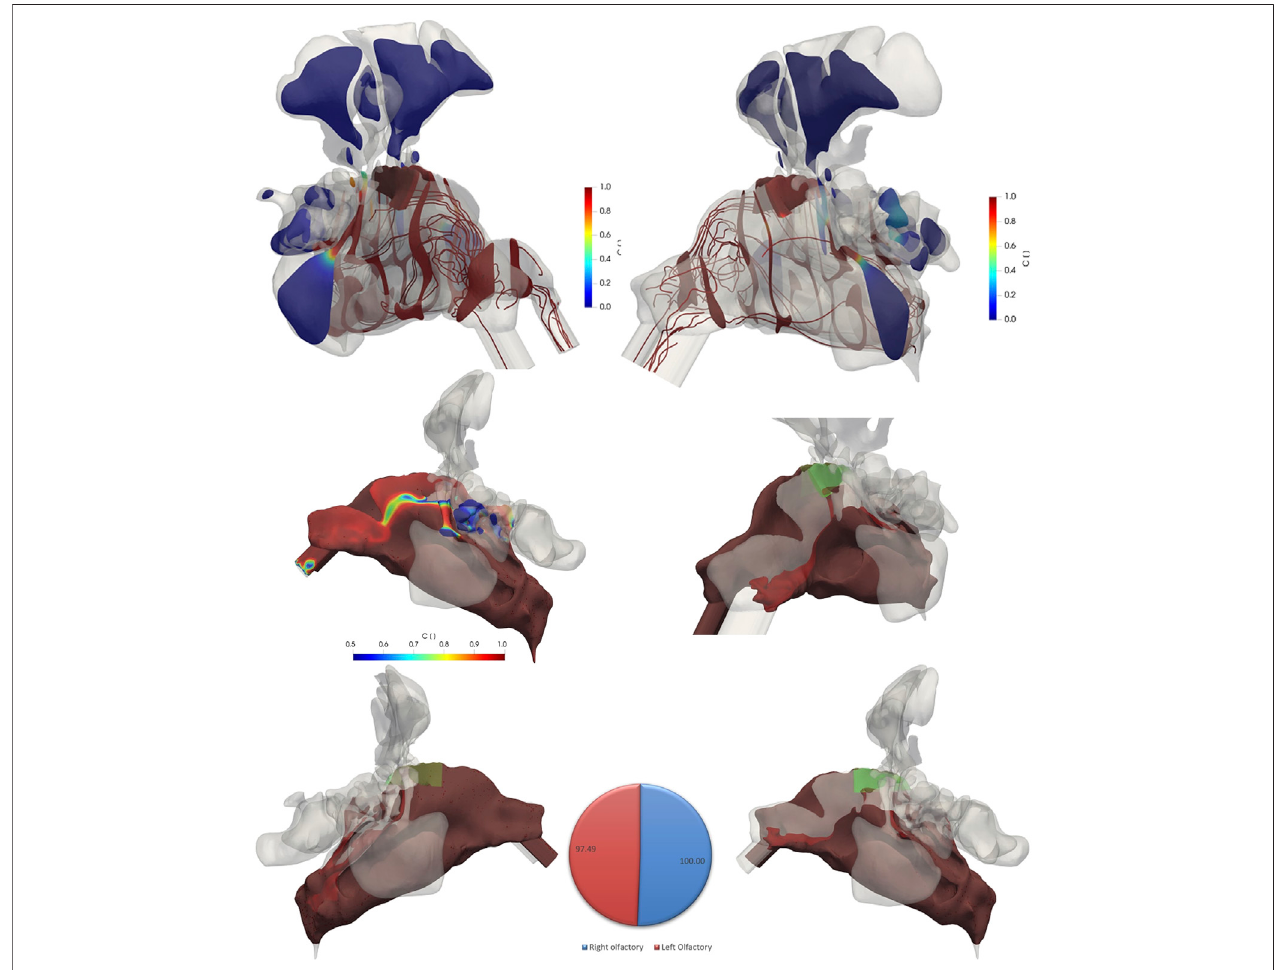
FIGURE 7 | The contour plots of variable C (drug-laden air fraction) and fl ow streamlines (color coded for C) in different regions of the nasal cavity speci fi cally in the olfactory region (green shaded) at t (cid:2) 1.98 s for pulsatile inlet fl ow of 4 L/min and frequency of 45 Hz. While the drug-laden air fraction is virtually identical to that of the non-pulsatile conditions (bottom and piechart), thestreamlinesinpulsatile air fl owhave more complexstructure after thenasal valvemoving the airtodifferentdirections andstreamlinesofthenon-pulsatileair fl owmovingstraightafterthenasalvalve.Theiso-volumesofvariableCforvaluesmorethan0.99fromleftandrightviewsas wellasclose-upviewoftheleftcavityareshownatthebottom.Aniso-volumeofvariableCwithvaluesmorethan0.5isshowninthemiddle fi gureforabettervisualization of values.